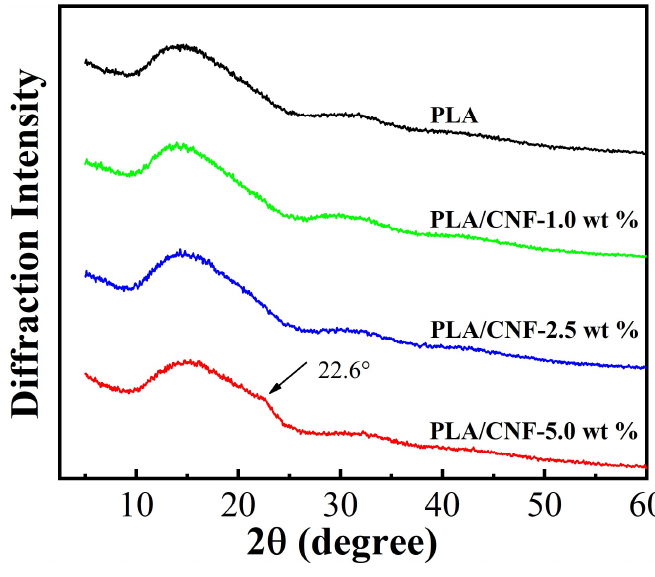
Figure 6. XRD patterns of PLA/CNF biocomposite films .